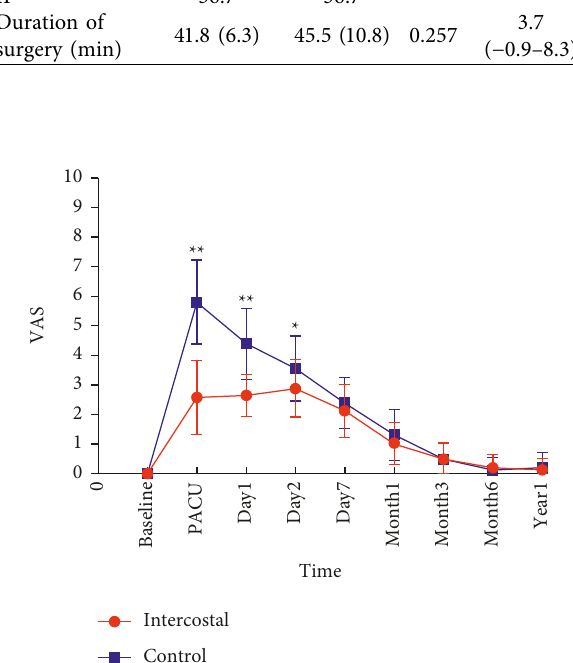
Figure 3: VAS scores after surgery. ∗∗ P < 0 . 01 and ∗ P < 0 . 05. VAS, Visual Analog Score; PACU, postanesthesia care